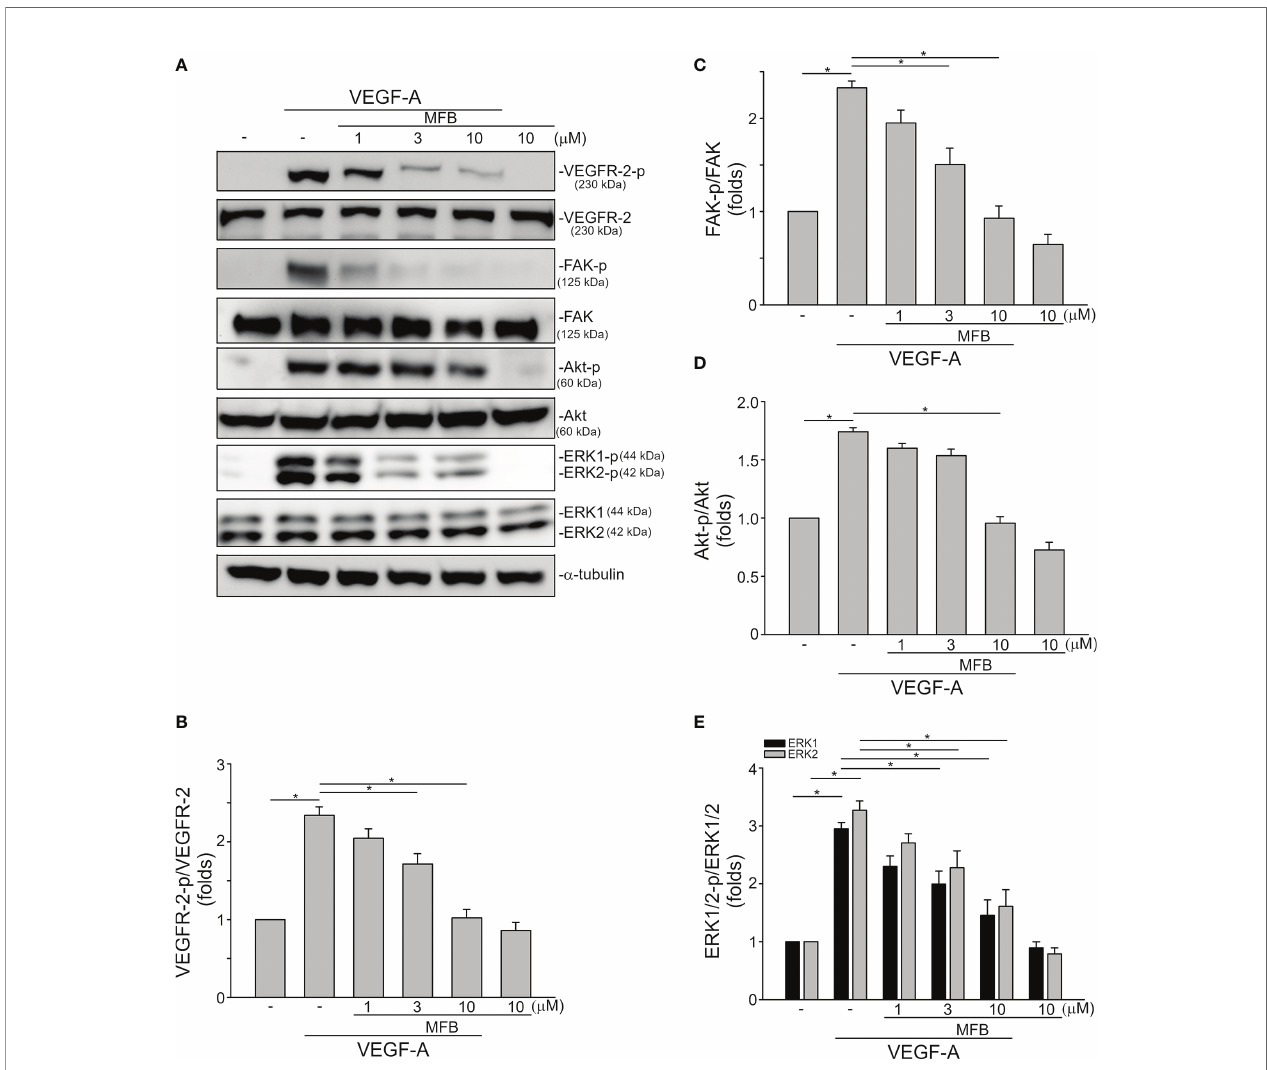
FIGURE 4 | MFB suppressed VEGF-A/VEGFR-2 signaling in HUVECs. (A) HUVECs were treated with MFB for 30 min, followed by the stimulation with VEGF-A (25 ng/ml) for another 5 (VEGFR-2) or 30 (FAK, Akt, and ERK1/2) min. The phosphorylation status of VEGFR-2, FAK, Akt, and ERK1/2 was determined by immunoblotting. The compiled results of VEGFR-2 Tyr1175 (B) , FAK Tyr397 (C) , Akt Ser473 (D) , and ERK1/2 Thr202/Tyr204 (E) phosphorylation are shown. Each column represents the mean ± S.E.M. of six independent experiments. *P <.05, signi fi cantly different from VEGF ‐ A alone; ANOVA on Ranks, with Kruskal-Wallis